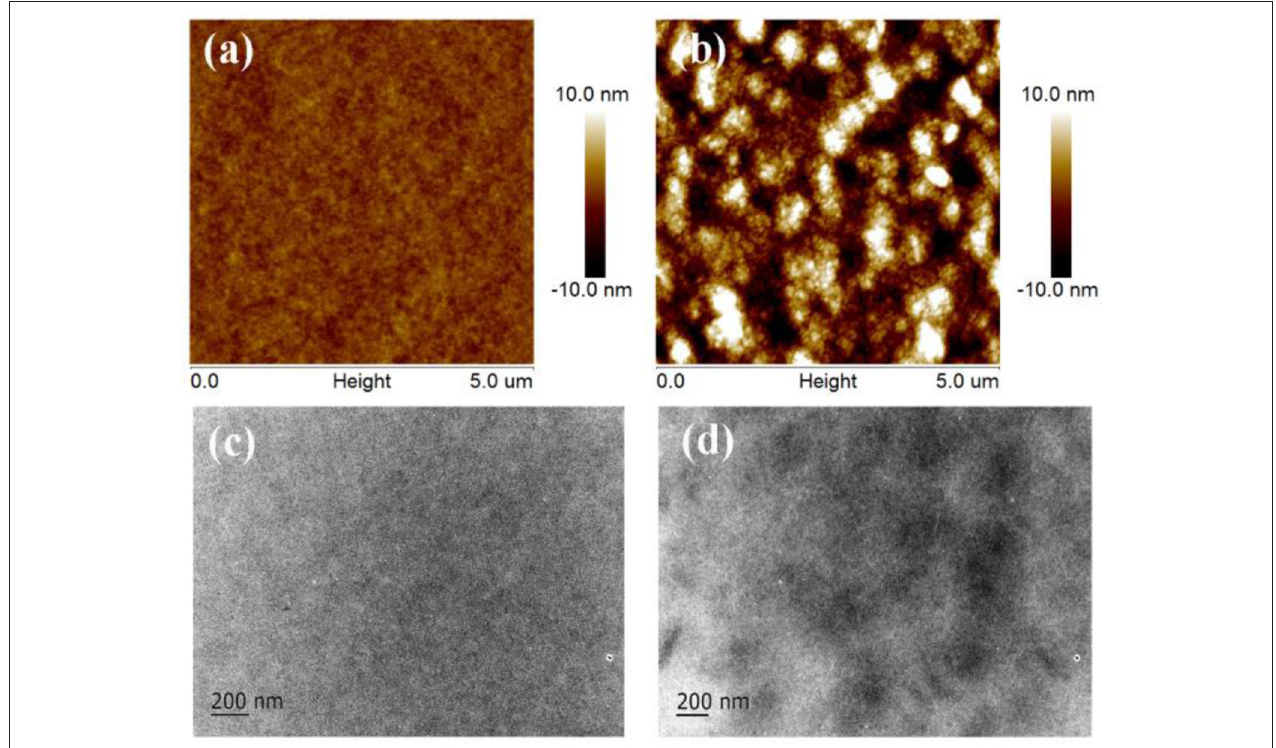
FIGURE 4 | AFM and TEM images of the blend films of PTB7-Th:truxene-PDI acceptor: (A,C) PTB7-Th:Tr-3PDI, (B,D)